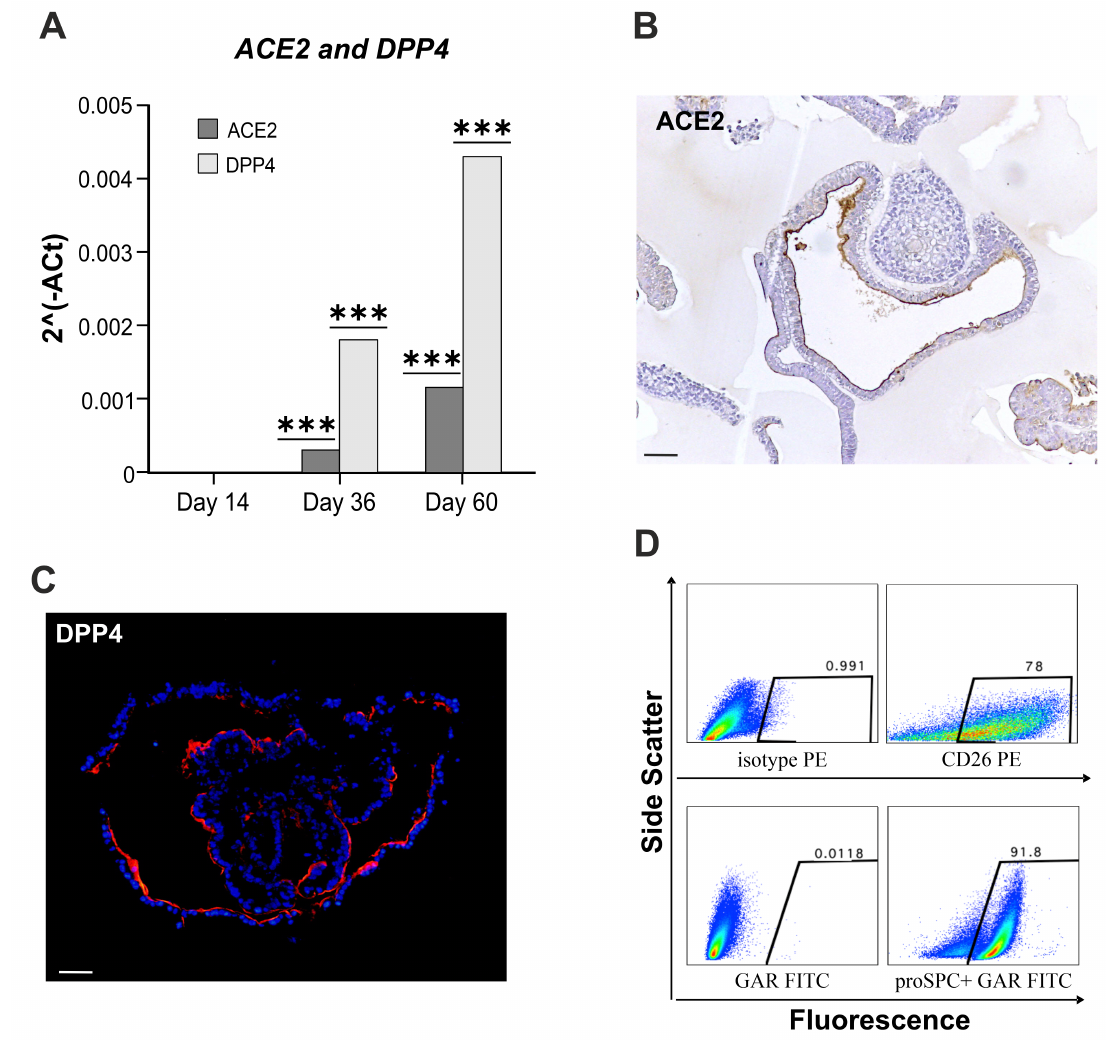
Figure 3. Expression of spike receptors . ( A ) RT–qPCR analyses of SARS-COV2 receptors (i.e., ACE2 , DPP4 ) in hLORGs at days 14, 36, and 60 of differentiation. Data are representative of three independent experiments and reported as mean ± SD. *** p < 0.001 by one-way ANOVA test. ( B , C ) ACE2 and DPP4 protein expression in hLORGs at day 60 of differentiation by immunohistochemistry/immunofluorescence. Scale bar 50 µ m. ( D ) FACS analysis of surface DPP4 (CD26) and intracellular SFTPC (proSPC) in hLORG cells. In the first column the control plots (mouse IgG2a isotype PE and goat anti Rabbit FITC) are depicted, in the second column the frequencies of DPP4 positive cells (CD26) ( upper row ) and of SFTPC (proSPC) ( lower row ) are